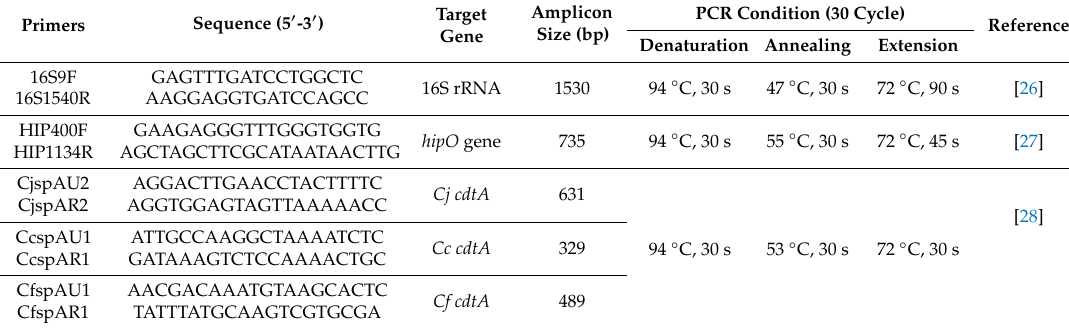
Table 2. Details of primers used in this